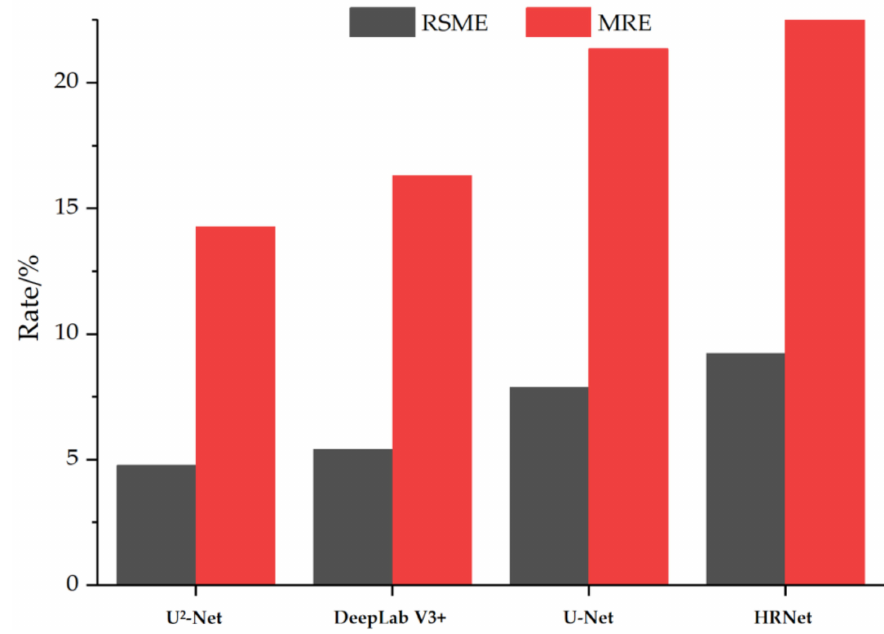
Figure 15. Comparison of the error rates for the different